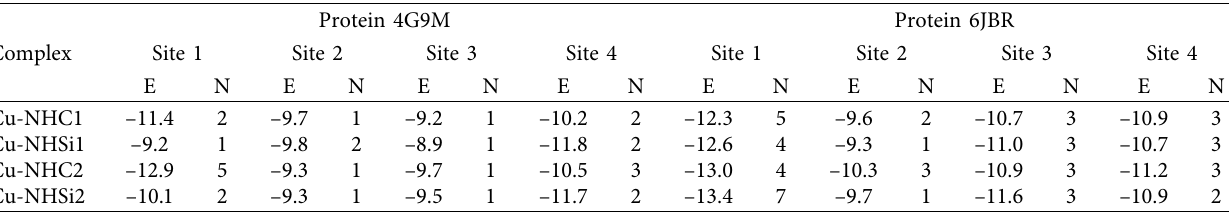
Table 4: Prescreening results on inhibitability of copper lighter tetrylenes Cu-NHC1, Cu-NHSi1, Cu-NHC2, and Cu-NHSi2 towards the potential sites on proteins 4G9M and 6JBR.